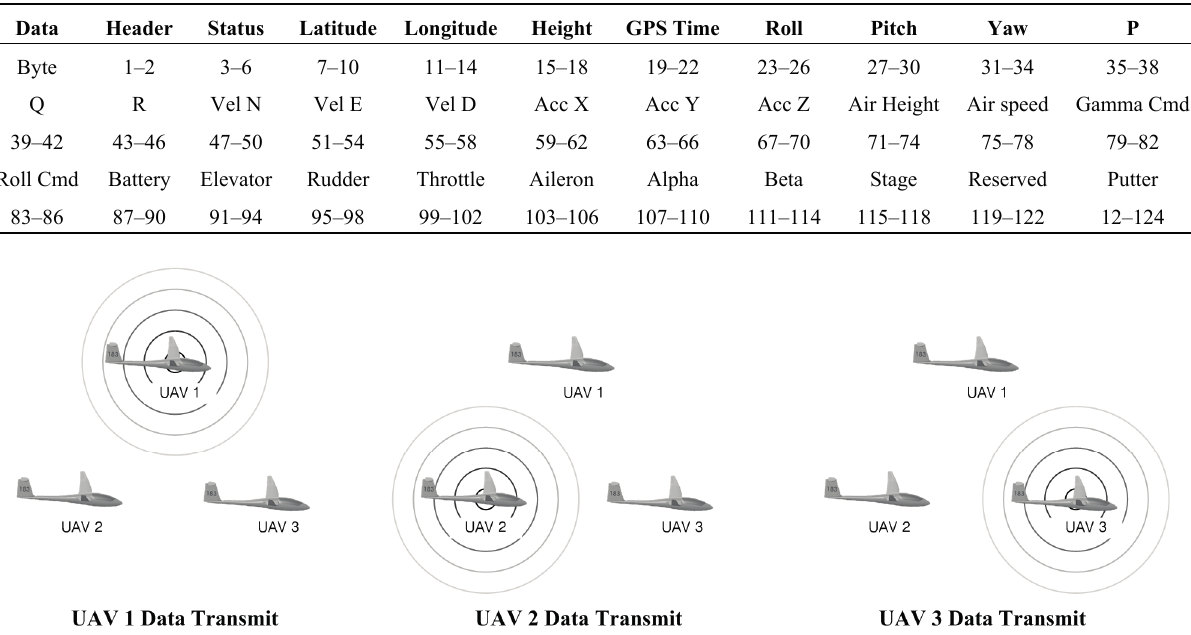
Table 3. Communication packets of the multi-UAV system.